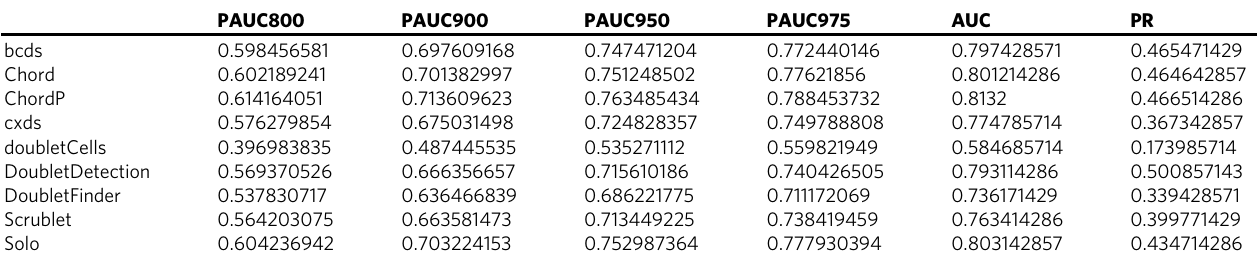
The average performance of various methods in all datasets. The indexes are the pAUC800, pAUC900, pAUC950, pAUC975, AUC and